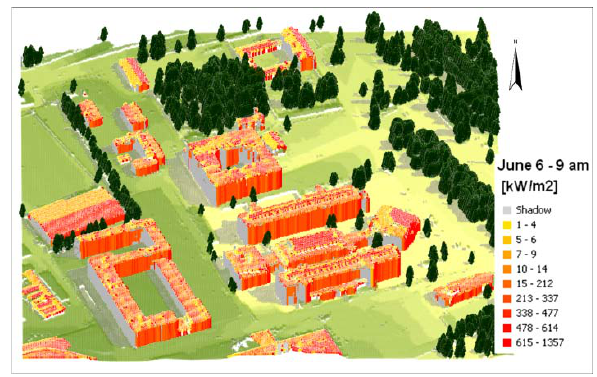
Figure 6. Radiation per unit area with 0.5h time steps (March, the 21 st ) [Wh/m 2 ]